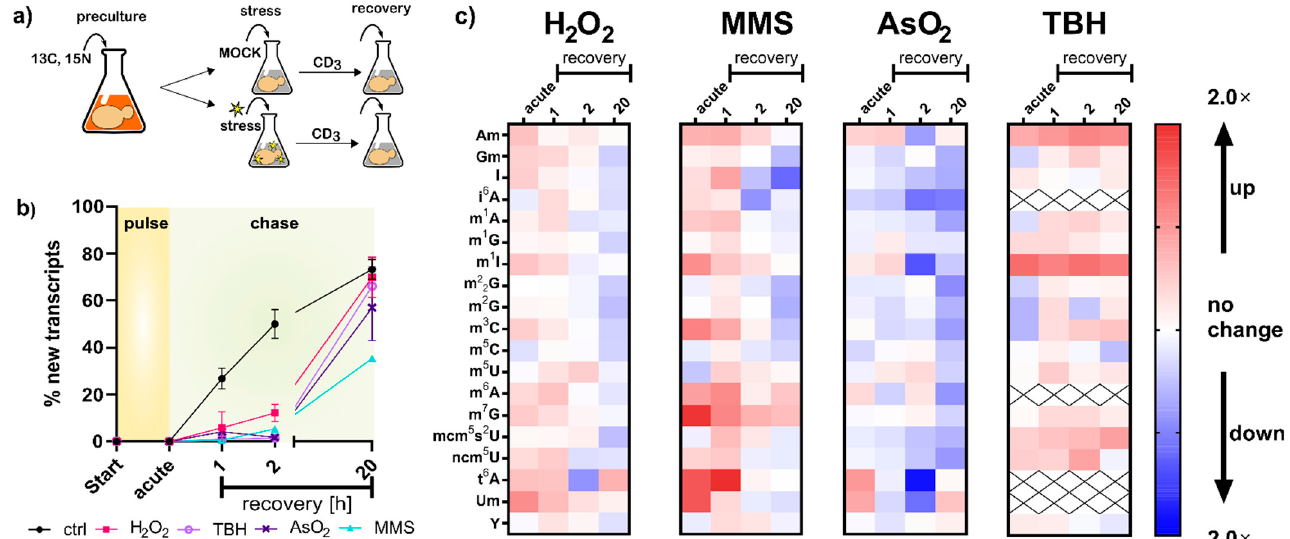
Figure 3. NAIL-MS pulse chase experiment with different stressors. ( a ) A concept sketch of the pulse-chase NAIL-MS assay. ( b ) Ratios of new and original tRNA transcripts displayed as percentages of new transcripts with the LD 50 dose; data from n = 3 biological replicates; error bars reflect standard deviations. ( c ) Relative abundances of modified nucleosides in total tRNA compared to the time-matched control. The resulting fold changes in red indicate higher modification densities, and blue indicates lower abundances. Data are averages from three biological replicates.